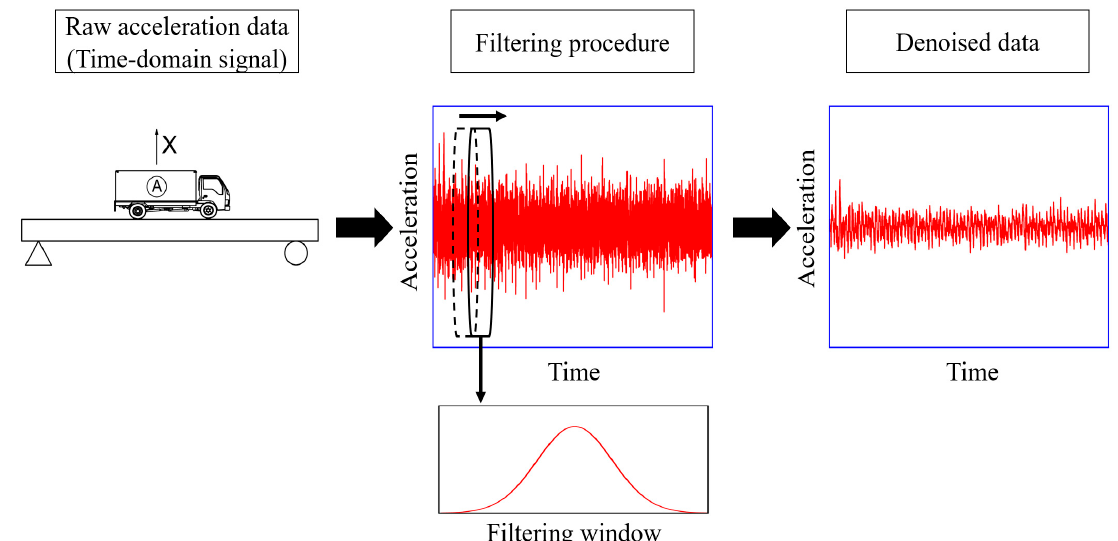
Figure 2. Data acquisition with fi ltering operation.